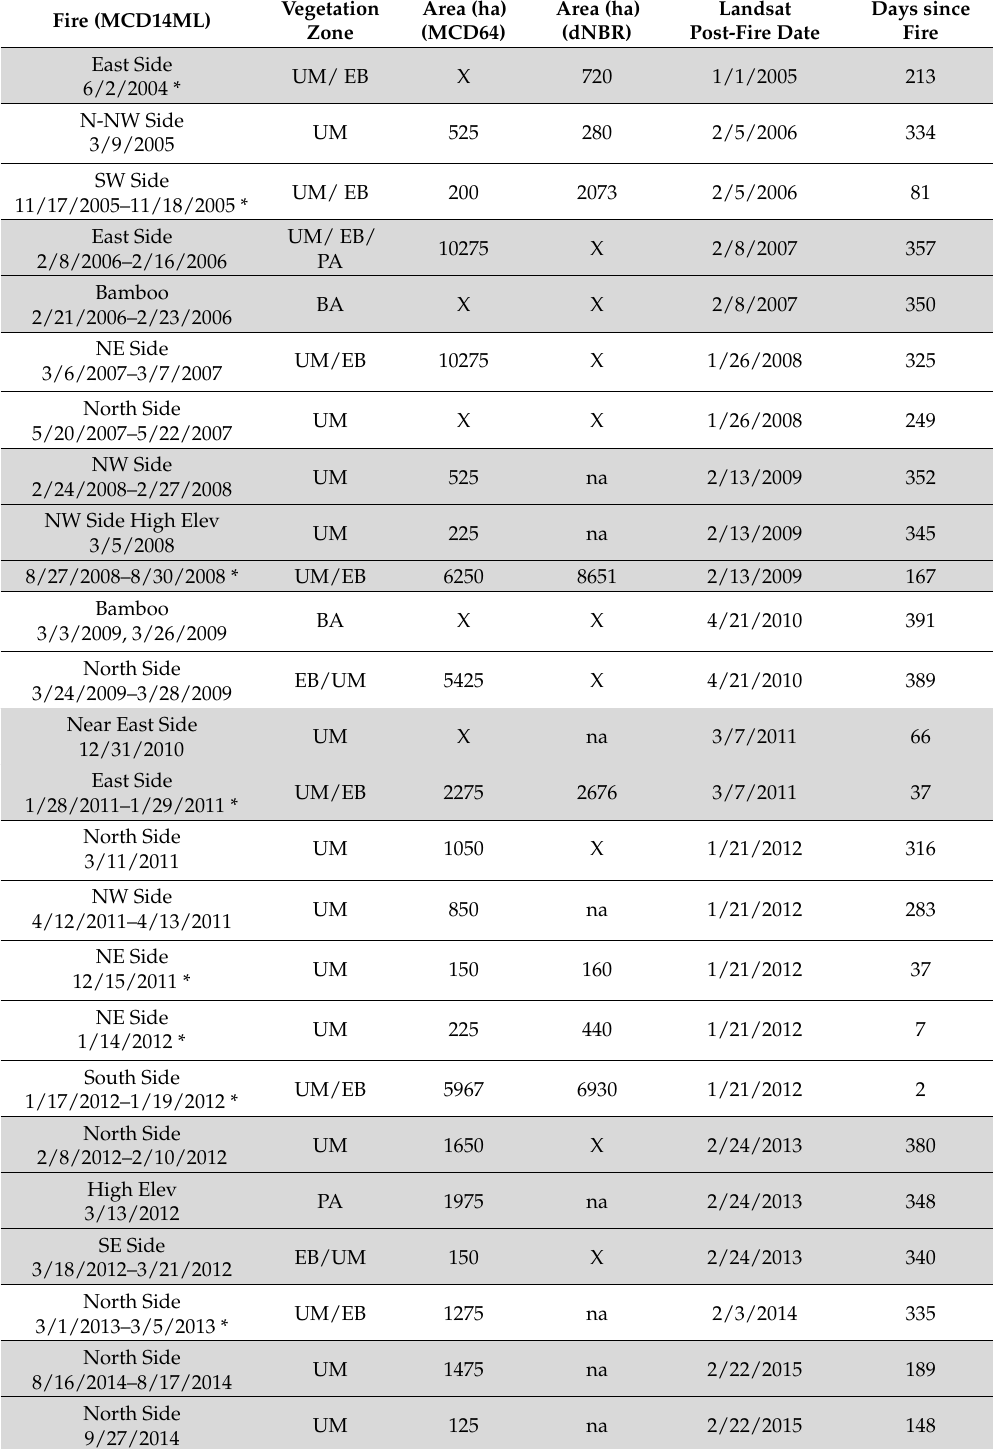
Table 8. Summary of fires detected using Landsat dNBR, MODIS active fire, and MODIS burned areas. BA = bamboo forest, EB = ericaceous bushland, UM = upper montane forest, PA = paramo. Fires marked with * are those included in Section